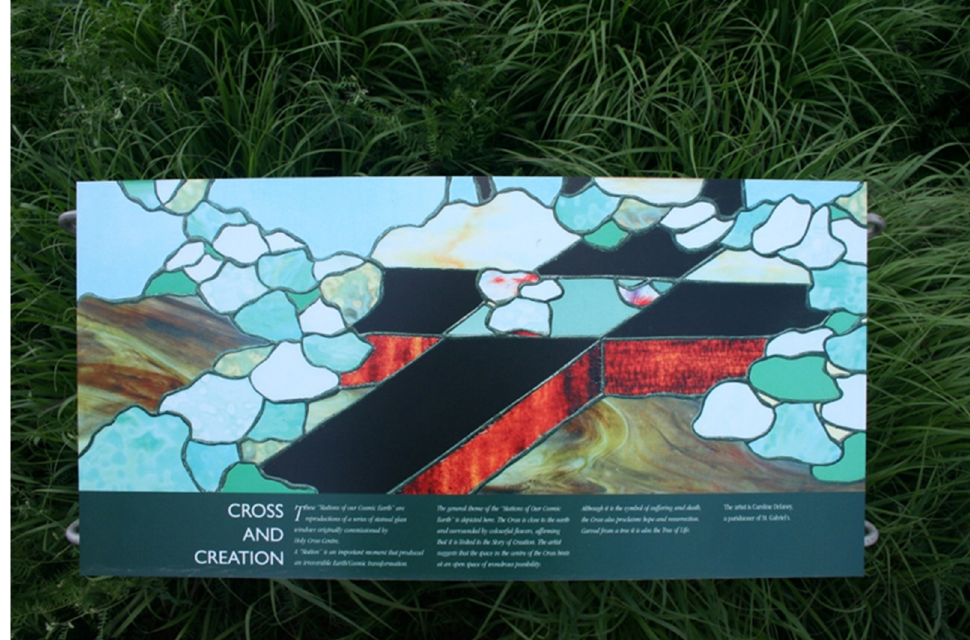
Figure 12. The station (which is not part of the sequence) depicting the cross. Each station has a written description of the image with accompanying mediation (Photo Credit: Roberto Chiotti).